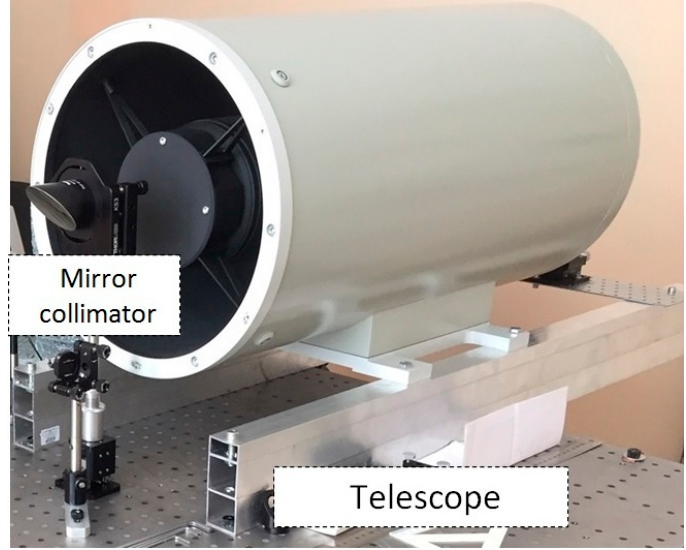
Figure 3. Cassegrain receiving telescope and mirror